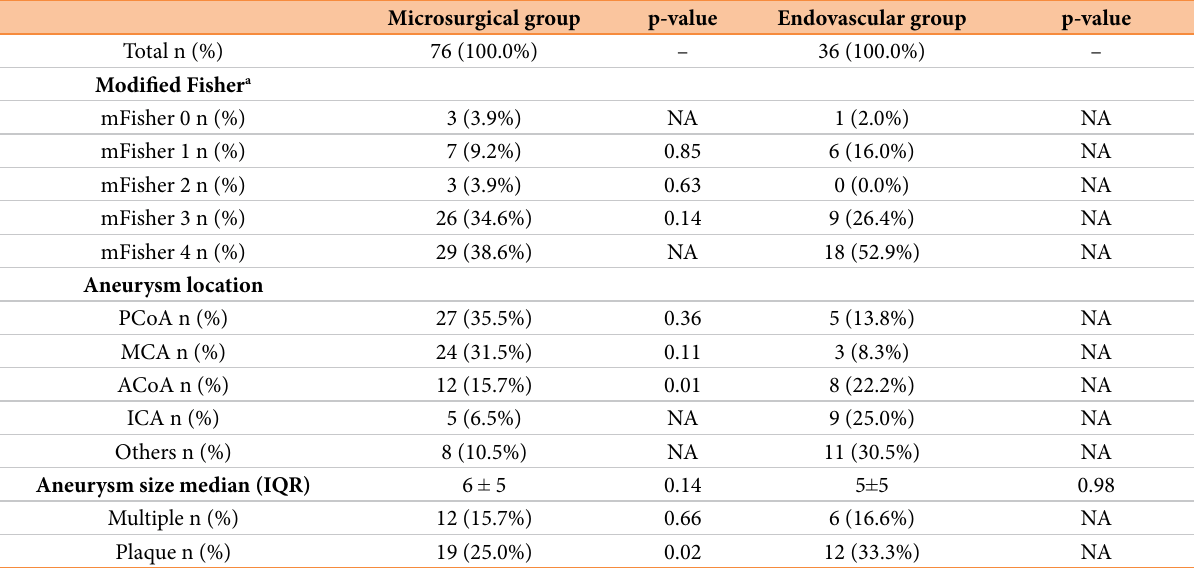
Table 4 - Radiological features and death at discharge. mFisher was assessed in 75 patients from the microsurgical group and 34 patients from the endovascular